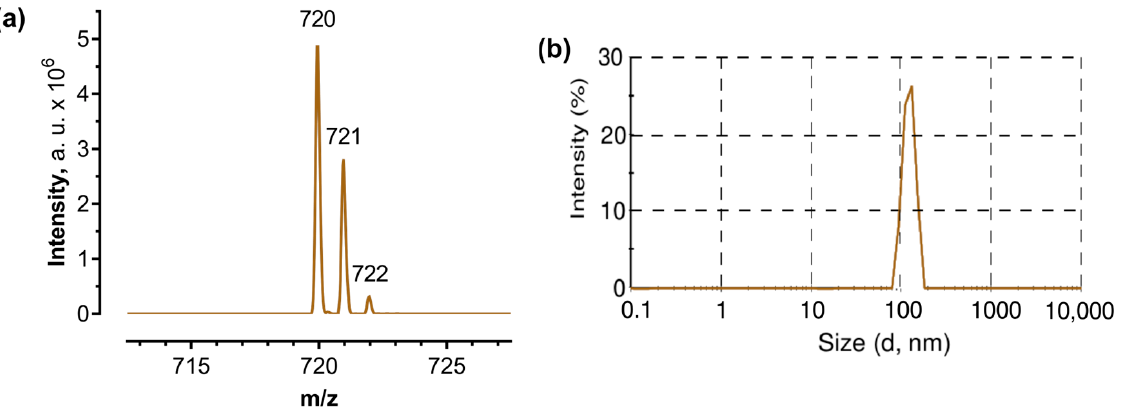
Figure 1. C 60 aqueous colloid solution: ( a )—MALDI-TOF-MS spectrum of C 60 colloid solution, a.u. = arbitrary units; ( b )—Hydrodynamic size (diameter, nm) of 20 µM C 60 , Intensity (%): percentage of all scattered light intensity.